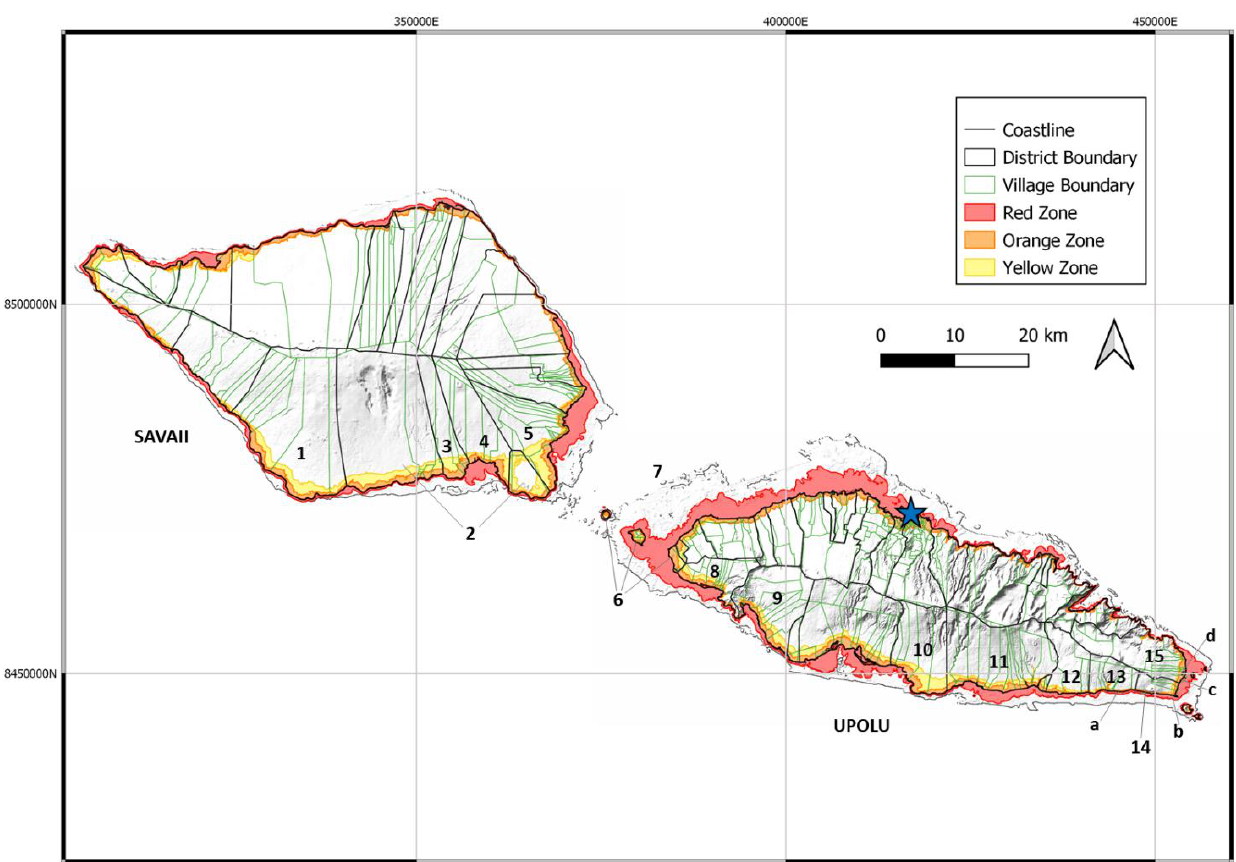
Figure 1. Samoan Islands showing district and village boundaries, as well as the extents of the red, orange, and yellow tsunami evacuation zones [20]. Red zone denotes areas at potential threat to small tsunami which pose only a marine threat. Orange zone encompasses all areas at potential threat to tsunami inundation from regional/distant earthquakes which are not locally felt. Yellow zone denotes all areas at potential threat to tsunami inundation following a long and strongly felt earthquake. Districts located along southeast Upolu experienced the greatest losses in terms of casualties, damage to property and the built environment from the 2009 tsunami. Districts cited in text: 1 = Palauli West; 2 = Palauli I le Falefa; 3 = Satupaitea; 4 = Palauli East; 5 = Faasaleleaga-I; 6 = Aiga I le Tai; 7 = Aana Alofi-III; 8 = Falelatai/Samatau; 9 = Lefaga/Faleseela; 10 = Siumu; 11 = Falealili; 12 = Lotofaga; 13 = Lepa; 14 = Aleipata Itupa I Luga; 15 = Aleipata Itupa I Lalo. Villages cited in text: a = Saleapaga; b = Lalomanu; c = Satitoa; d = Malaela. Star = Apia city.